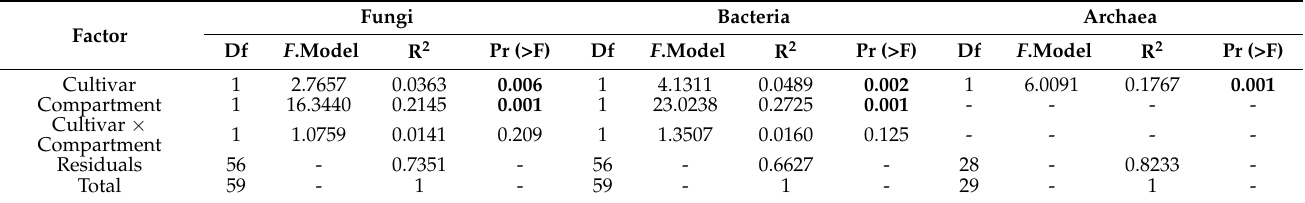
Table 3. PERMANOVA analysis of the effects of the cultivar, plant compartment, and their interaction on fungal community structure, based on Euclidean